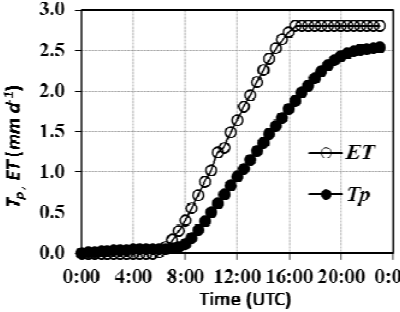
Figure 5. The daily cumulative upscaled SF Tp and EC ET during the image acquisition day. Each data point of transpiration represents the upscaled average of three trees.